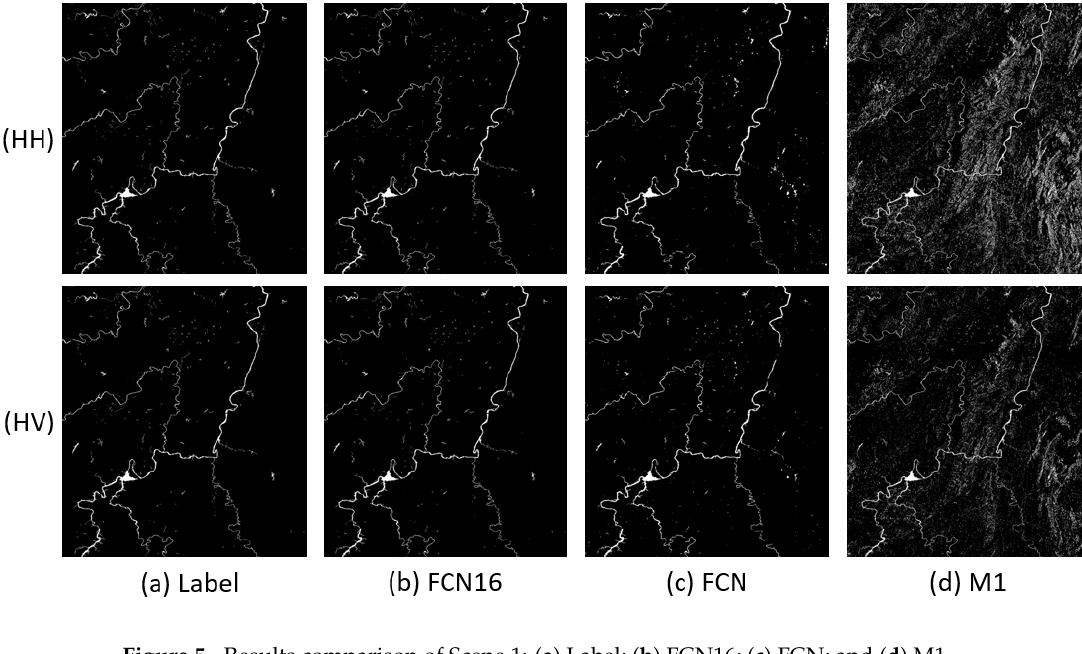
Figure 5. Results comparison of Scene 1: ( a ) Label; ( b ) FCN16; ( c ) FCN; and ( d ) M1.